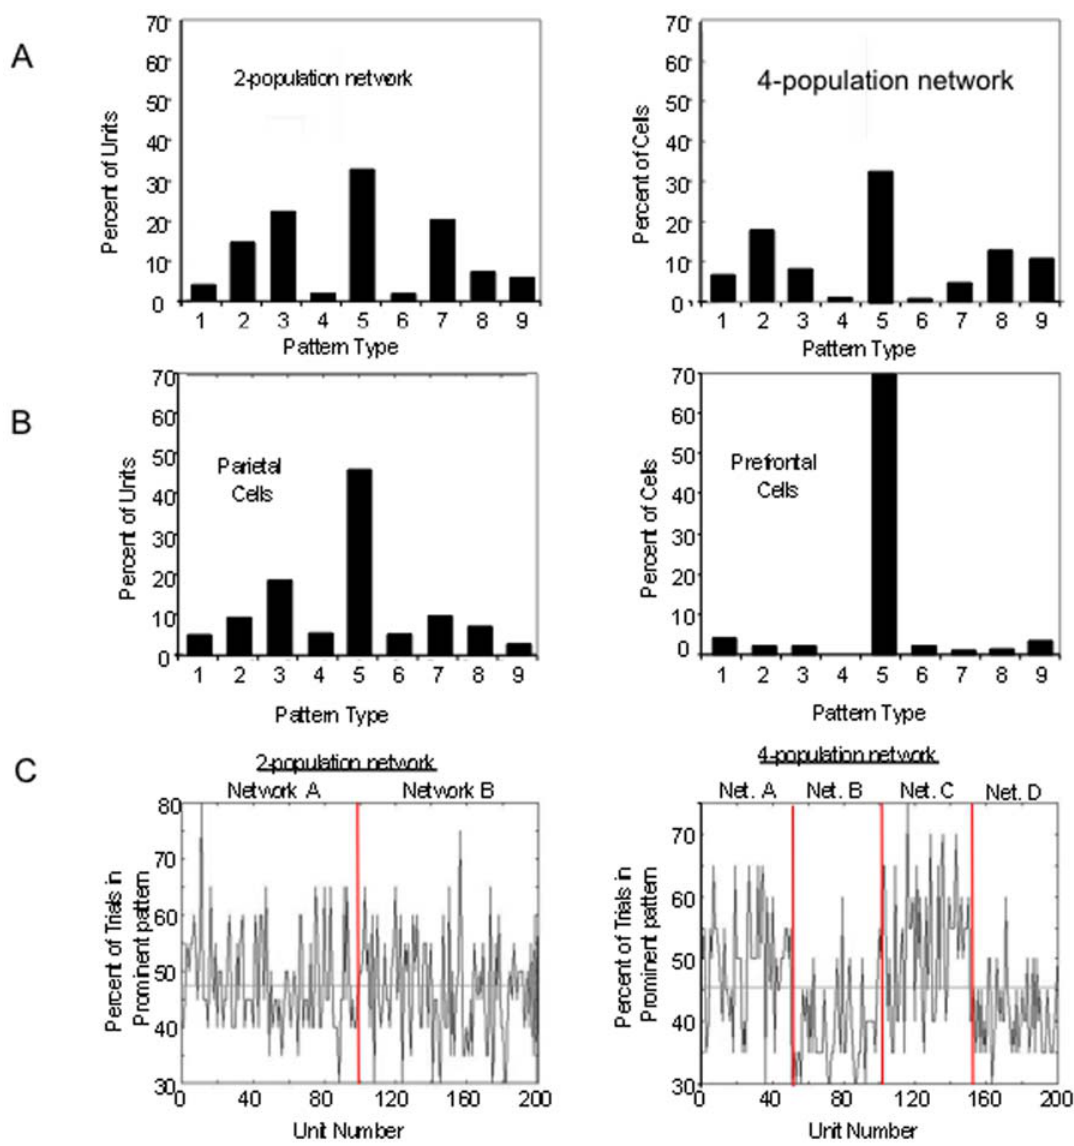
Figure 9. Distributions of units exhibiting the different pattern types in the spiking models and variability in pattern expressed from trial to trial in the units of those models. A) Distribution of pattern types exhibited by units in the 2- and 4-population spiking models (left and right respectively). Distributions correspond to the average number of units exhibiting each pattern type over 20 trials of the simulated working memory task. Pattern numbers correspond to the same patterns as labeled in table 4. Specifically 1) Ramping cells 2) fixed rate memory cells, 3) Decaying memory cells 4) ramping set cell with no frequency difference between D1 and baseline, 5) nonresponsive cell 6) ramping inhibited cell with no frequency difference between D1 and baseline, 7) decaying inhibition cell, 8) fixed rate delay inhibited cell, and 9) ramping delay inhibited cell B) Distribution of the percentage of parietal (left) and prefrontal (right) cells exhibiting each pattern type during the performance of unimodal and cross-modal working memory tasks. Note that the distribution of the real cells and the units in the spiking model are similar with nonresponsive cells being most common, excitatory memory cells (decaying, fixed rate, and ramping) being the next most common, and inhibitory patterns (decaying, fixed rate, and ramping) being the least common. Also patterns 4 and 6 (ramping excitatory and inhibitory cells with no frequency differences between D1 and baseline) occur infrequently in both the models and real cells. C) Consistency of pattern type expressed across trials for each of the 200 units in the 2-population spiking model (left) and the 4 population spiking model (right). Each unit was classified as displaying one of the pattern types in its average PSTH histogram (across 20 trials). The ordinate indicates the percentage of trials in which the dominant pattern (the pattern occurring most often across trials and is typically that which is observed in the averaged PSTH histogram) of the average was actually exhibited by the unit. In the 2-population graph, units 1–100 are all members of one population, while units 101–200 are part of the other population. In the 4-population graph, units 1–50, 51–100, 101–150, and 151–200 are the members of populations 1 through 4 respectively. Note that the overall average variability in pattern expression is the same in the 2- and 4-population models, with the classified pattern type of each unit being displayed in approximately 47% of the trials, and an approximate range of 30–70% of trials showing different patterns on any given trial. However, while the variability is distributed evenly across both populations in the 2-population model, in the 4-population model the variability is significantly greater in units in those populations exhibiting primarily inhibitory patterns (populations 2 and